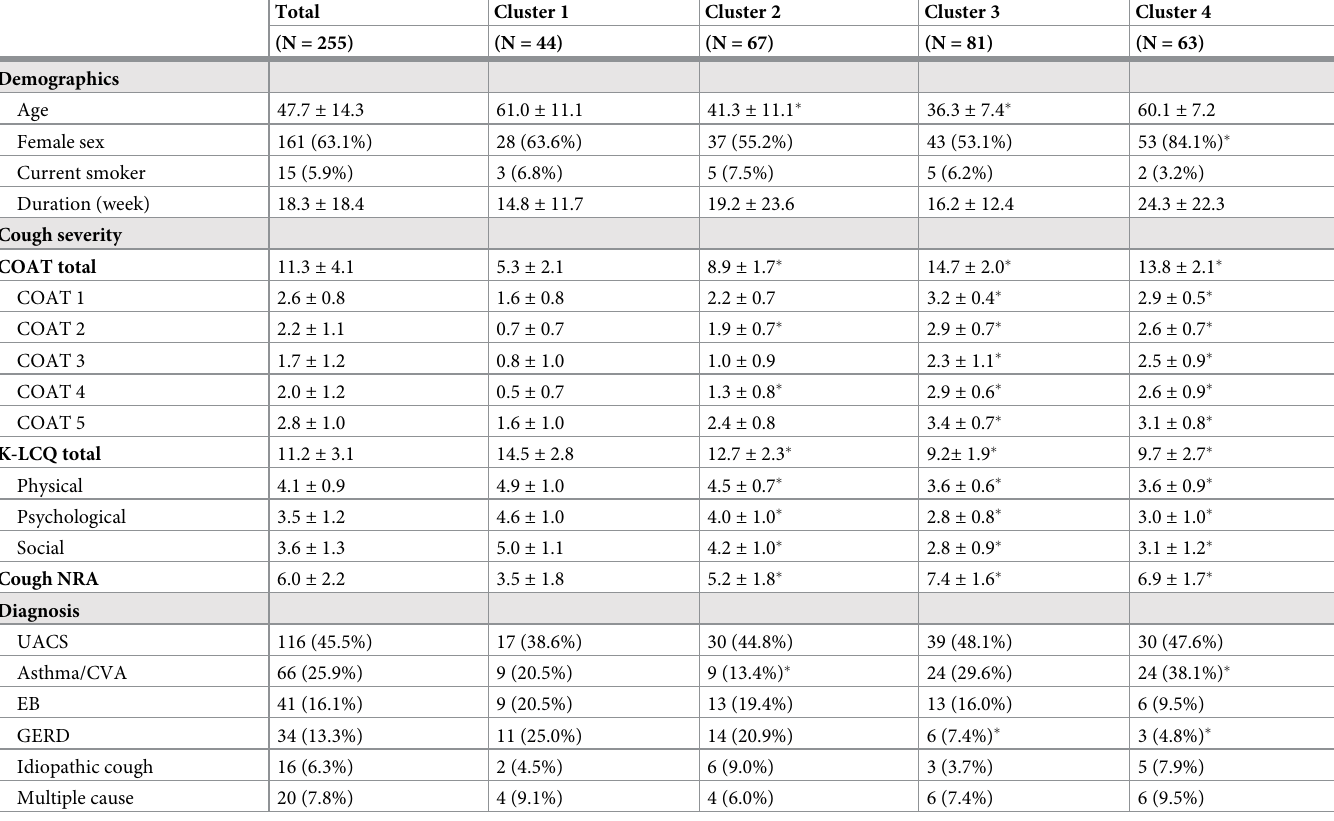
Table 1. Baseline characteristics of the entire study population and that compared between clusters of patients with chronic cough.